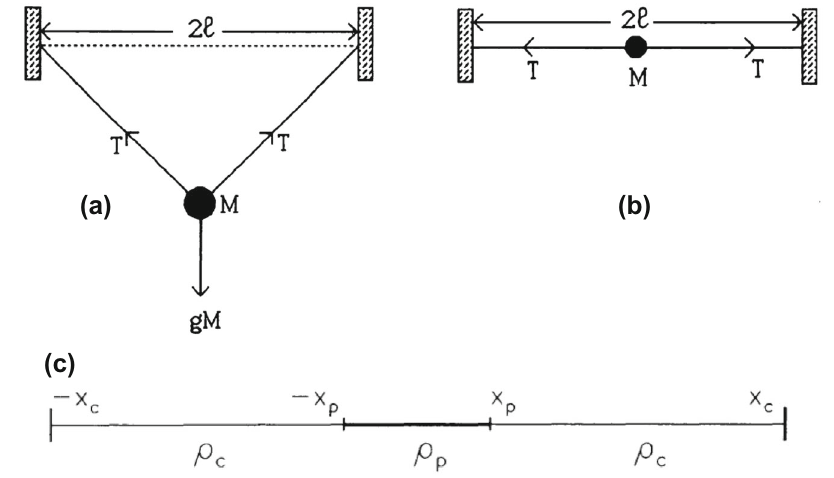
Fig. 33 Simple models of a prominence. a Mass suspended from an elastic string under the influence of gravity and the tension force. b Mass suspended from a taut string subject solely to the tension force. Bottom: Taut string with density ρ c except for a central part with density ρ p ; gravity is also neglected. The size of the system (2 (cid:13) in a , b and 2 x c in c ) is denoted by 2 L in the text. Images reproduced with permission from (top) Roberts (1991), copyright by Taylor & Francis; and (bottom) from Oliver et al. (1993) copyright by